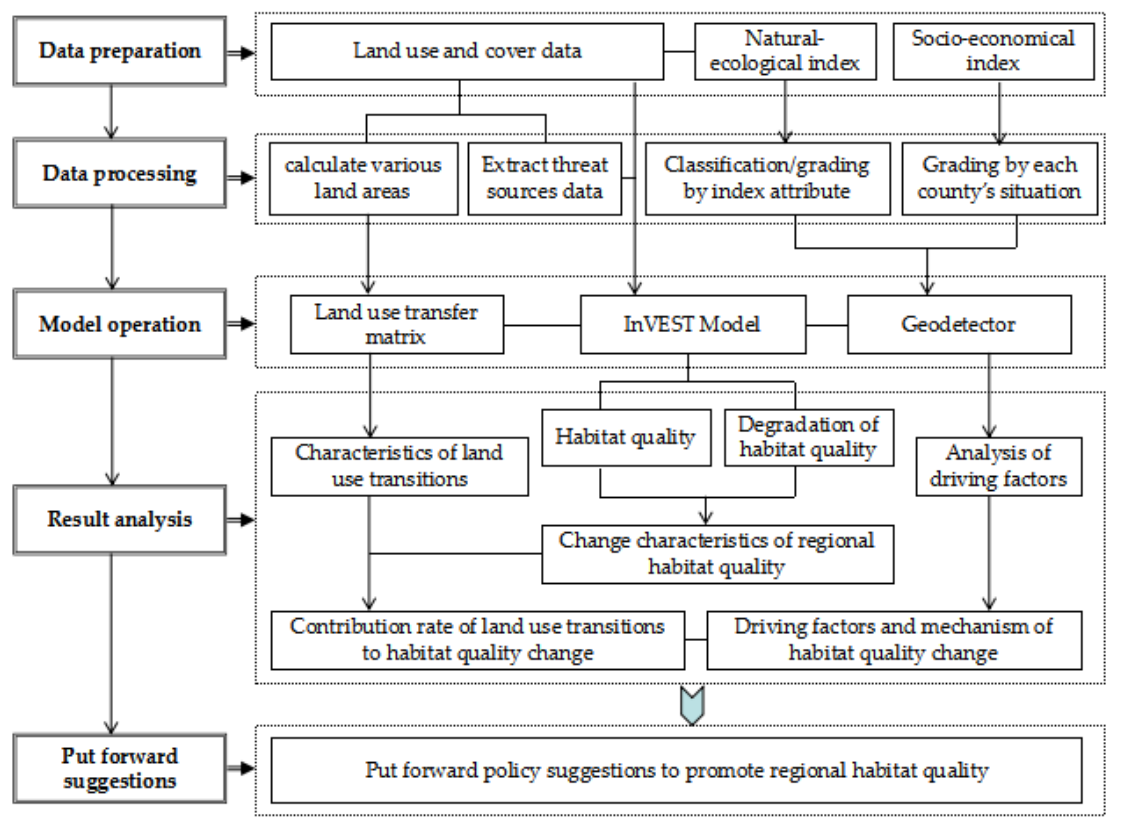
Figure 2. Research logic and process of this study.